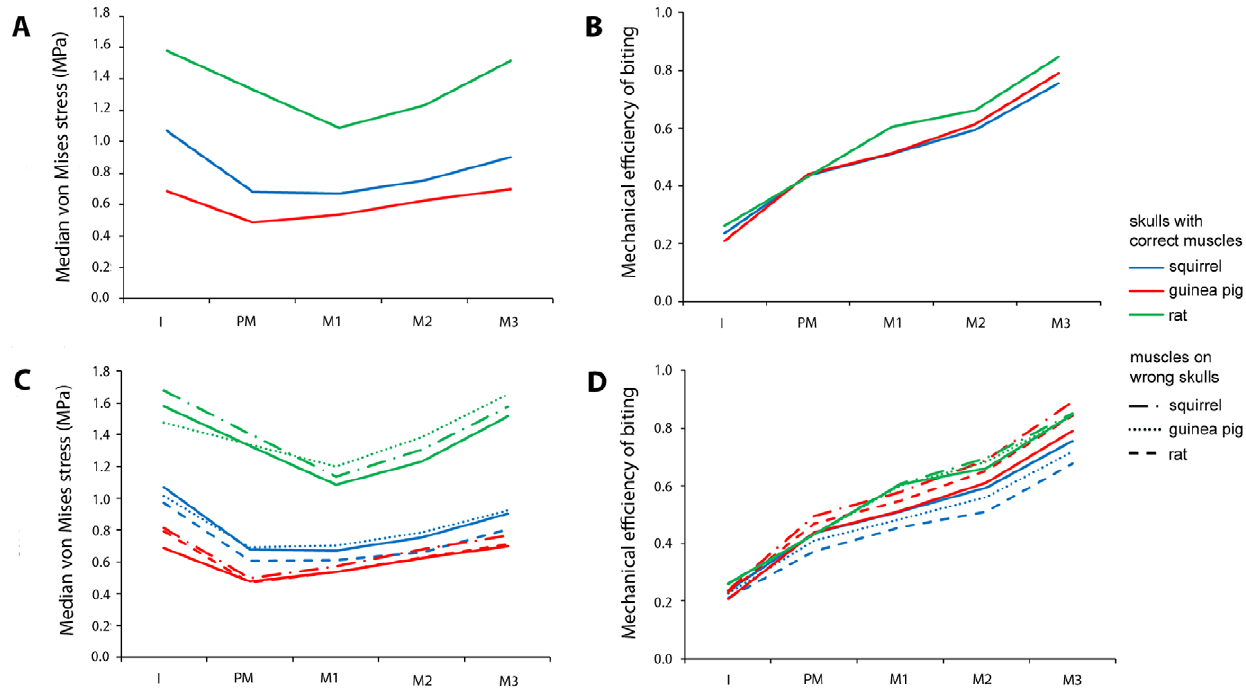
Figure 4. Biting performance of rodents at each tooth. (A) Median von Mises stresses on the skull and (B) mechanical efficiency of biting (predicted bite force divided by total applied muscle force) in squirrels, guinea pigs and rats. (C) Median von Mises stresses and (D) mechanical efficiency of biting of each of the three models with the squirrel, guinea pig and rat muscle configurations applied in turn. I, incisor; PM, premolar (absent in rats); M, Molar.